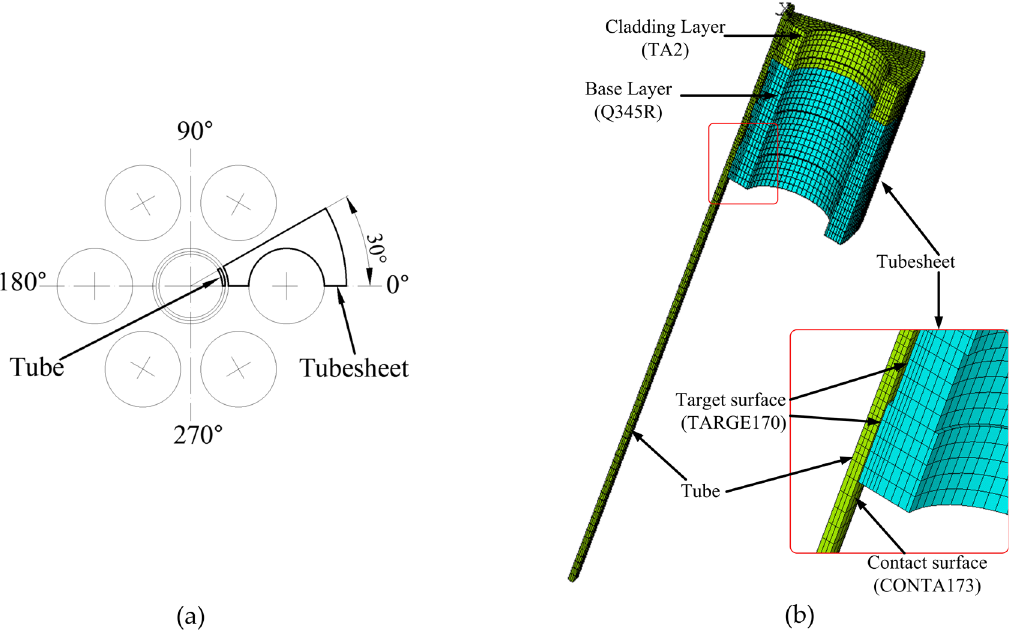
Figure 2. Finite element analysis: ( a ) analysis scope; ( b ) finite element mesh model.